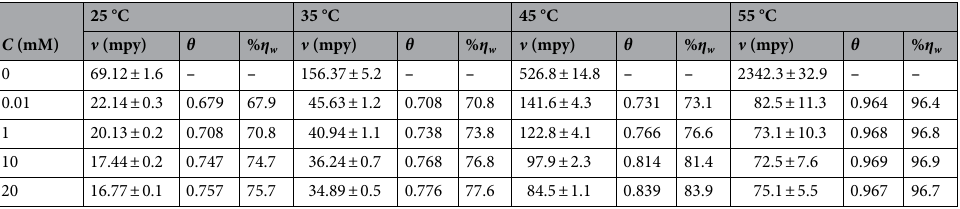
Table 1. Weight loss test results of MS following 6 h immersion in 5% HCl solution in the absence and occurrence of diverse concentrations of expired Ampicillin drug at varying temperatures. “ ± ” shows the standard deviation of three